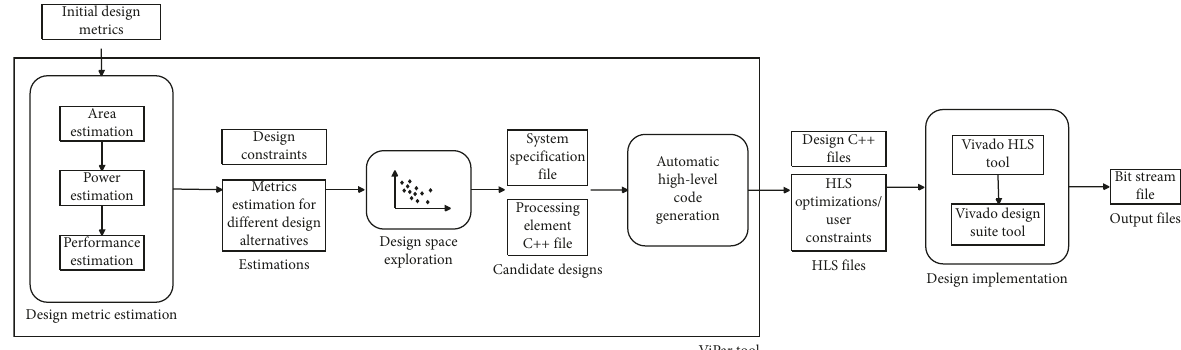
Figure 4: Design flow with ViPar tool.